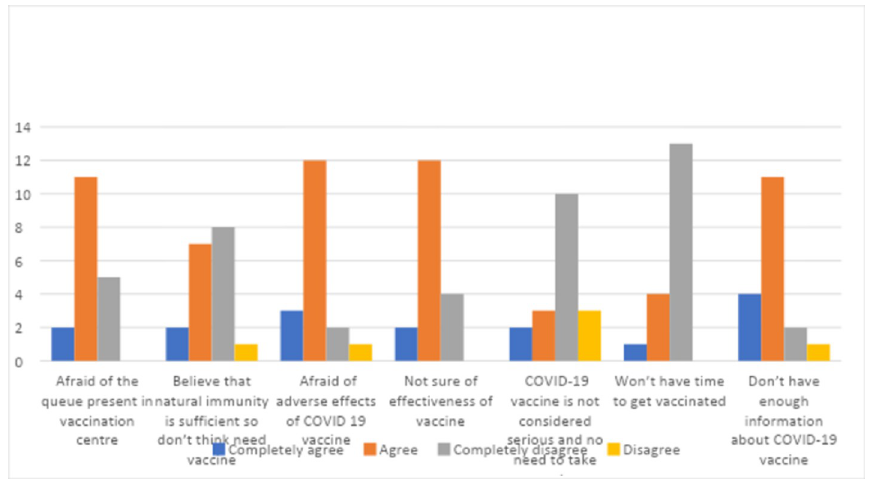
Fig 2. Hesitancy for COVID-19